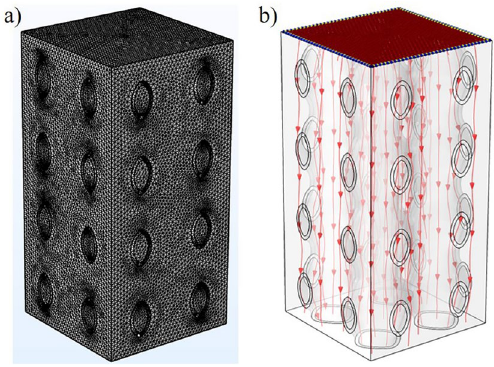
Figure 5. ( a ) Fluid domain meshing map; ( b ) cell initial distribution